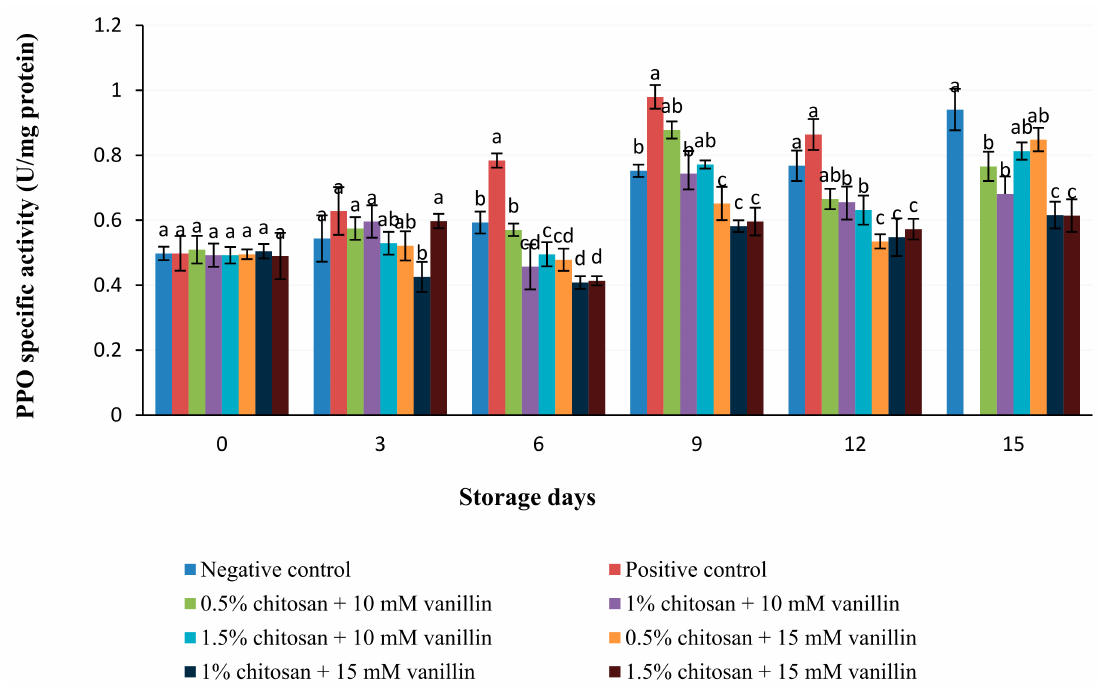
Figure 9. Effects of coating treatment on PPO specific activity in Fusarium oxysporum inoculated tomato fruit stored for 15 days at 26 ± 2 ◦ C and 60 ± 5% relative humidity. Mean values in a column followed by different letters for each storage day differed significantly by LSD at p ≤ 0.05. Vertical bars indicate standard error of means ( n = 24).